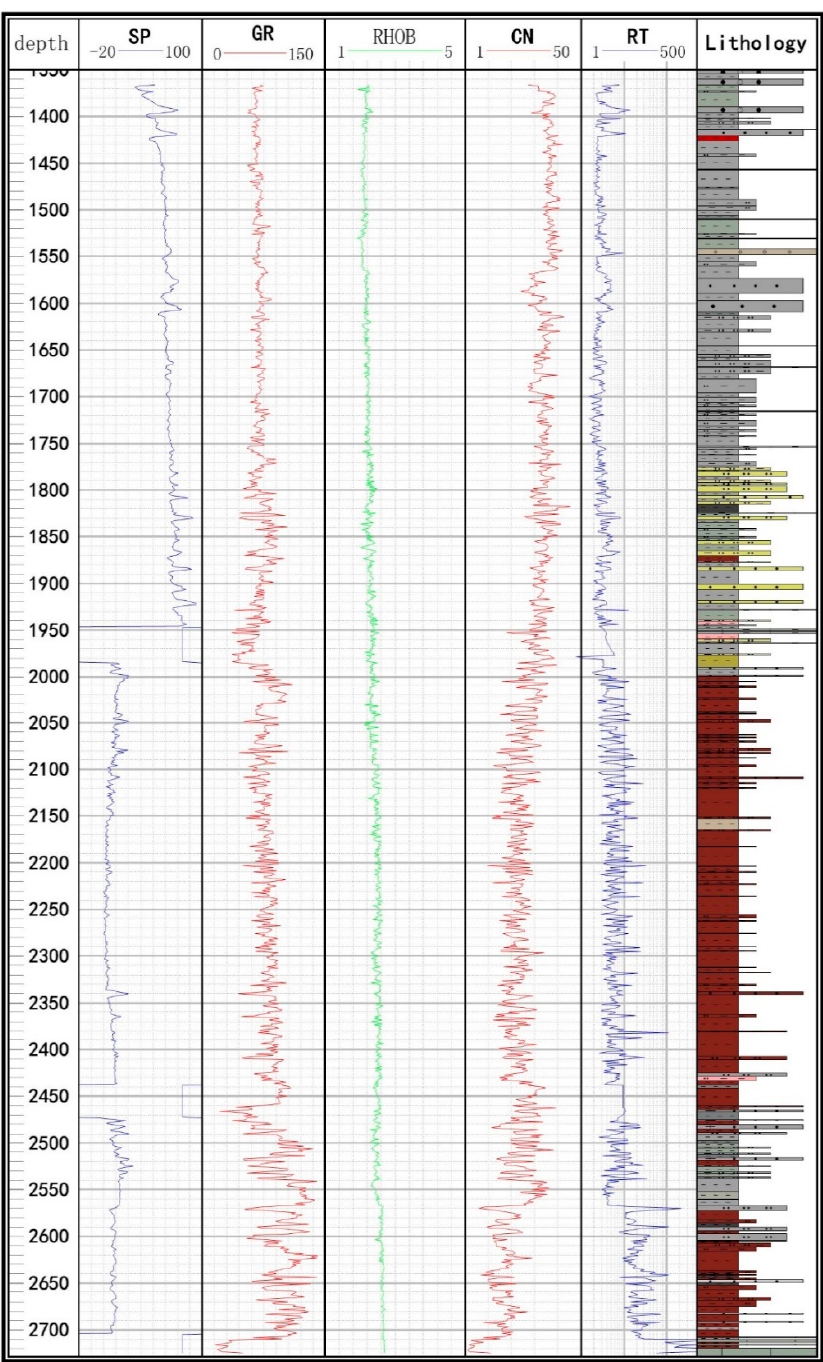
Figure 2. Geophysical well logs of SP: spontaneous potential; GR: gamma ray; RHOB: bulk density; CN: compensated neutron; and RT: resistivity, are in the study area corresponding to a visual characterization of the lithology (last track).